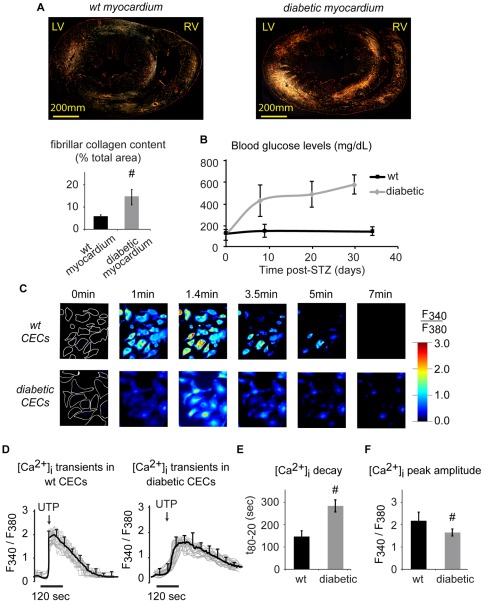
Diabetes induces cardiac fibrosis and alters [Ca2+]i transients in CECs.(A): Analysis of the Picrosirius red staining of diabetic myocardium using polarized light microscopy showed the presence of cardiac fibrosis with significantly increased area of fibrillar collagen fibers (yellow, orange or red, middle panel), as compared to mostly reticular fibers (green, left panel) in the myocardium of age-matched wild-type animals (LV, RV: left or right ventricle). (B): Rats injected with STZ showed significant and rapid hyperglycemia by day 5 that persisted throughout the study. (C–F): Significant differences in UTP-evoked [Ca2+]i transients were observed between wild-type and diabetic CECs (C, D). [Ca2+]i transients in individual cells (outlined in white in the first frame) obtained using ratiometric analysis are shown as grey lines, with the average transient as a black line. Analysis of transients (E–F) demonstrated significantly longer [Ca2+]i decay time and smaller peak amplitude in diabetic CECs, as compared to wild-type CECs (#: p<0.05; cell no: 206 (wt), 195 (db)).